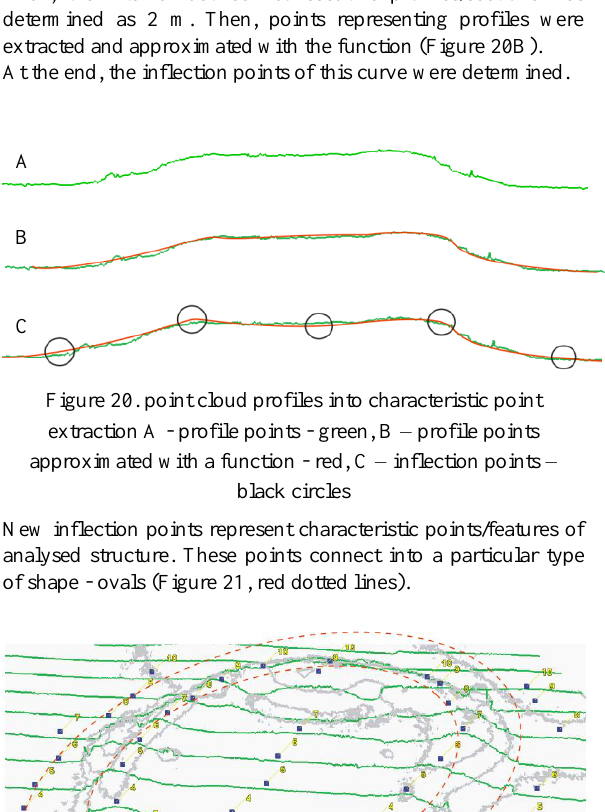
Figure 19. Point cloud generated using UAV imagery A – point cloud with RGB coding, B – point cloud after calssification According to processing scheme (Figure 4) point cloud was classified and filtered to bare ground.